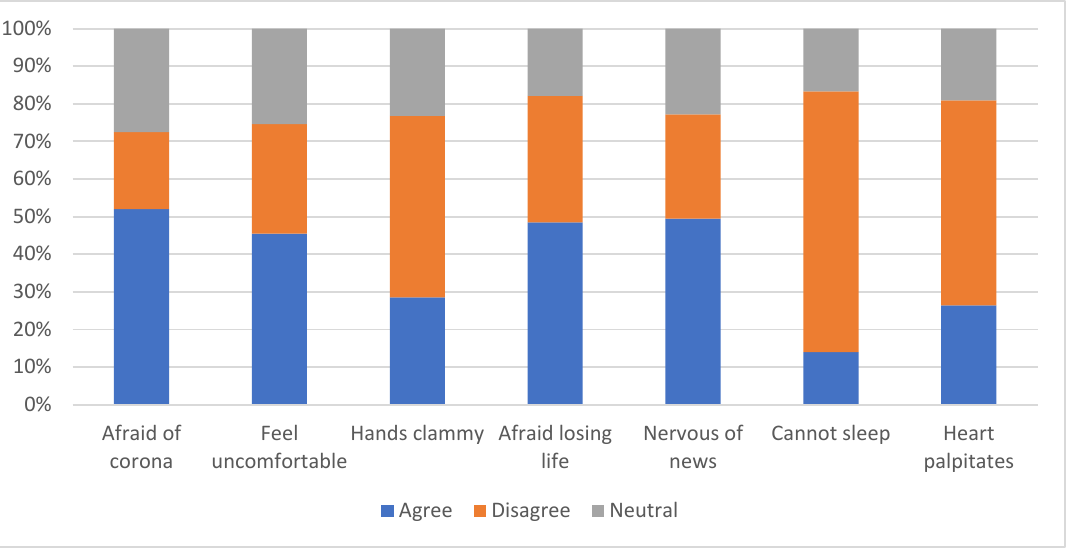
Figure 1. Multidimensional bar chart indicating fears associated with COVID-19 assessed by the Fear of COVID-19 Scale.